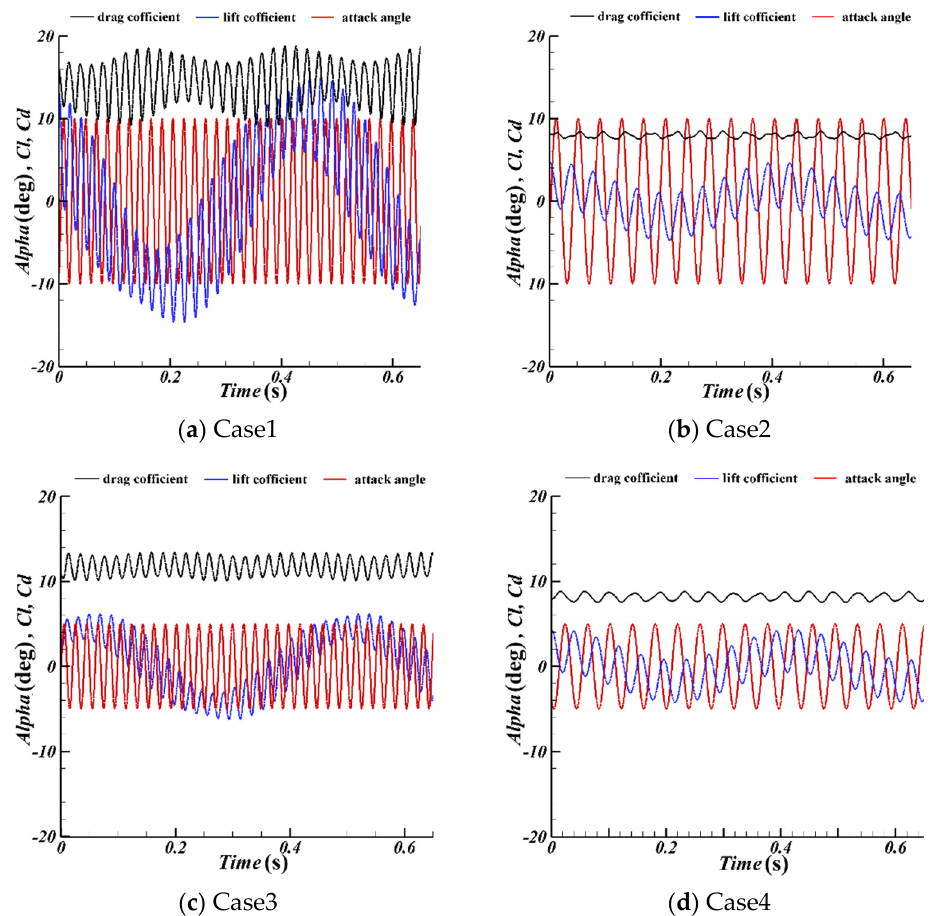
Figure 9. The curves of the attack angle, dimensionless lift coefficient, and dimensionless drag coefficient with time.